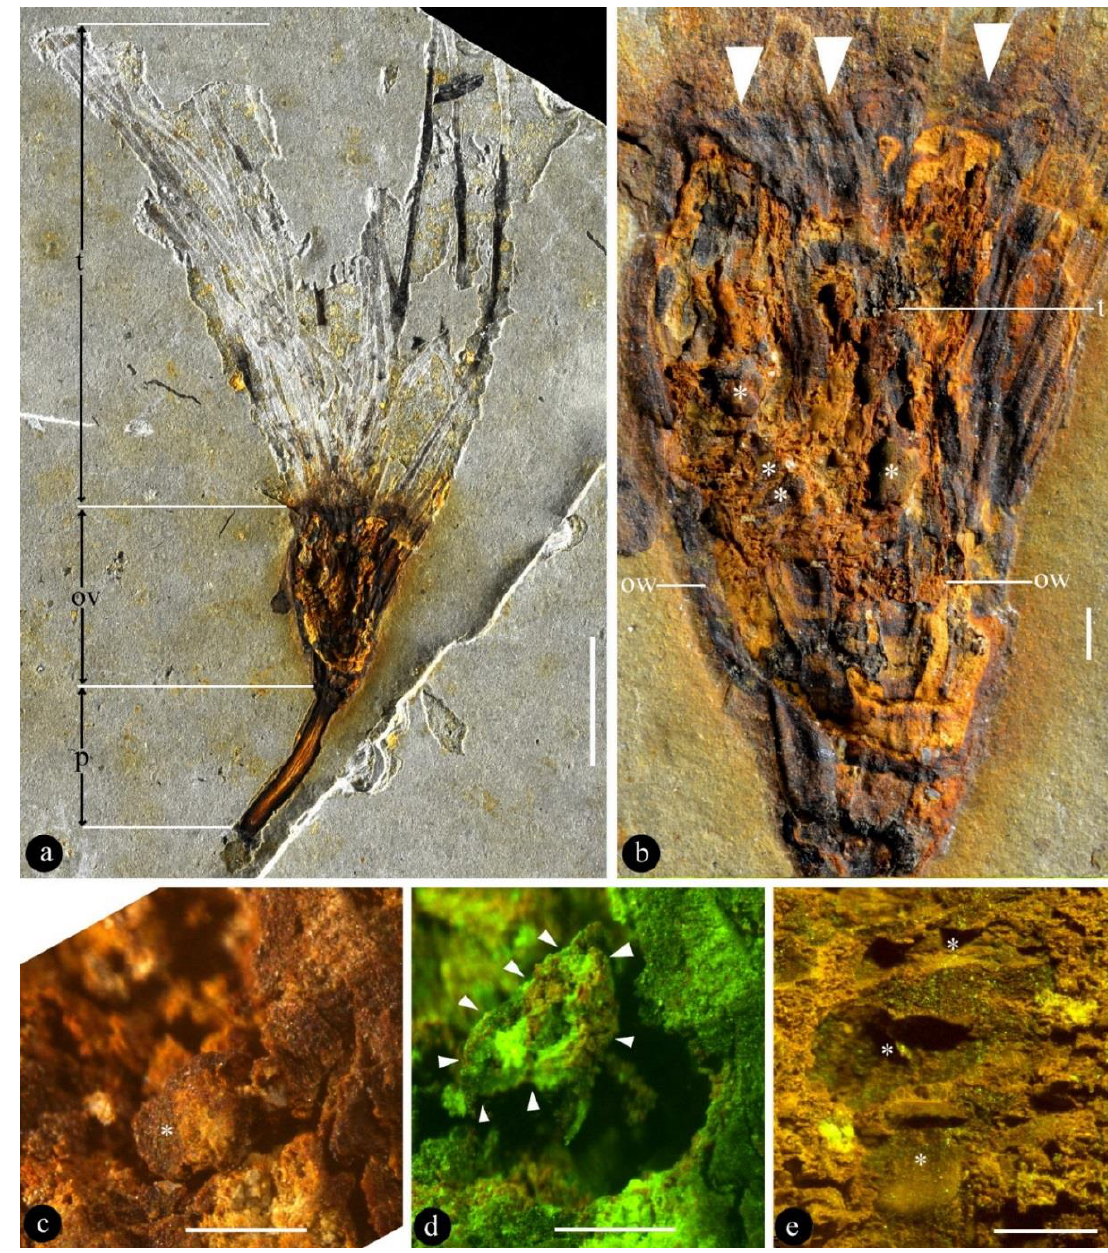
Figure 2. Lingyuananthus inexpectus gen. et sp. nov. and its details. ( a ) General view of the flower, showing pedicel (p), ovary (ov), and tepals (t). Scale bar = 1 cm. ( b ) Detailed view of the ovary, showing its obconical form, even top (triangles), ovary wall (=hypanthium) (ow), ovules (asterisks), and transmitting tissue (t). Refer to Figure 4c for details. Scale bar = 1 mm. ( c ) An ovule (asterisk) in situ in the ovary. Scale bar = 0.5 mm. ( d ) The ovule in Figure 2c, slightly dislocated from its original position, in the ovary. For papillae on the ovule, refer to Figure 4b. Scale bar = 0.5 mm. ( e ) Imprints left by three adjacent ovules (asterisks) of various forms in the ovary. Scale bar = 0.5